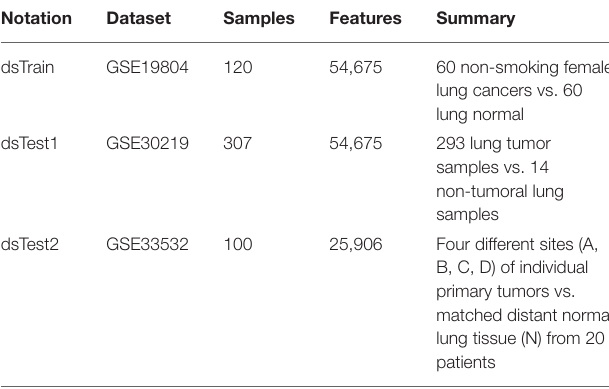
TABLE 1 | Summary of the three